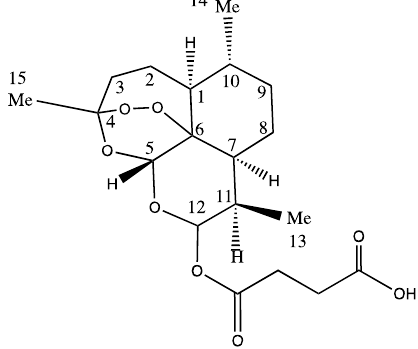
Figure 1. Chemical structure of